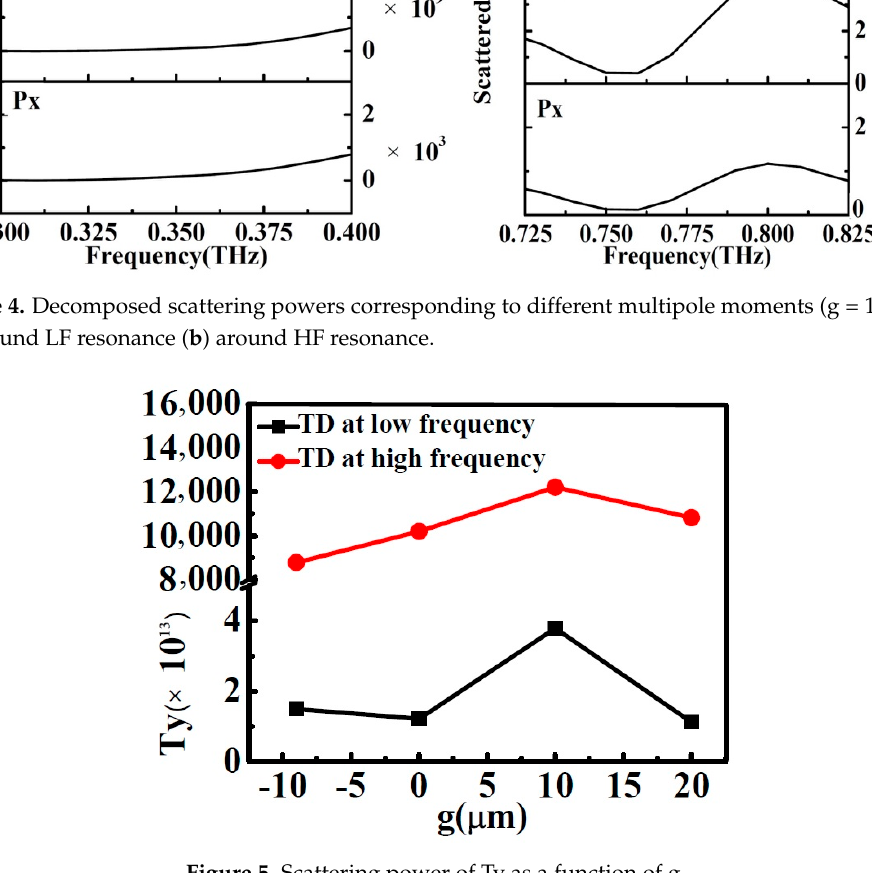
Figure 5. Scattering power of Ty as a function of g.